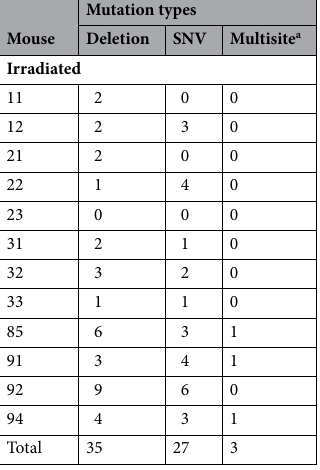
Table 2. Number of clonal hematopoiesis (CH)-associated non-mosaic mutations (VAF > 0.02) separated by mutation types. a Multisite mutations are clustered SNVs and insertions/deletions. SNV, single-nucleotide variation; VAF, variant allele